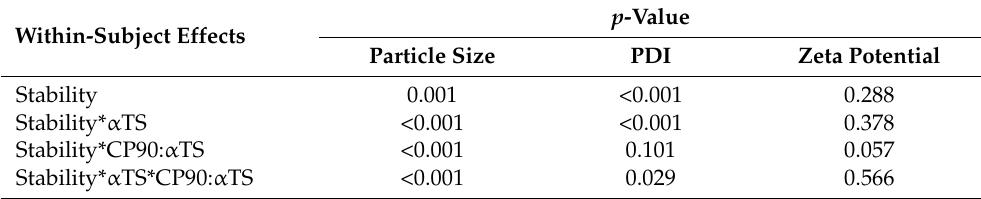
Table 4. Within-subject effects for repeated measures ANOVA